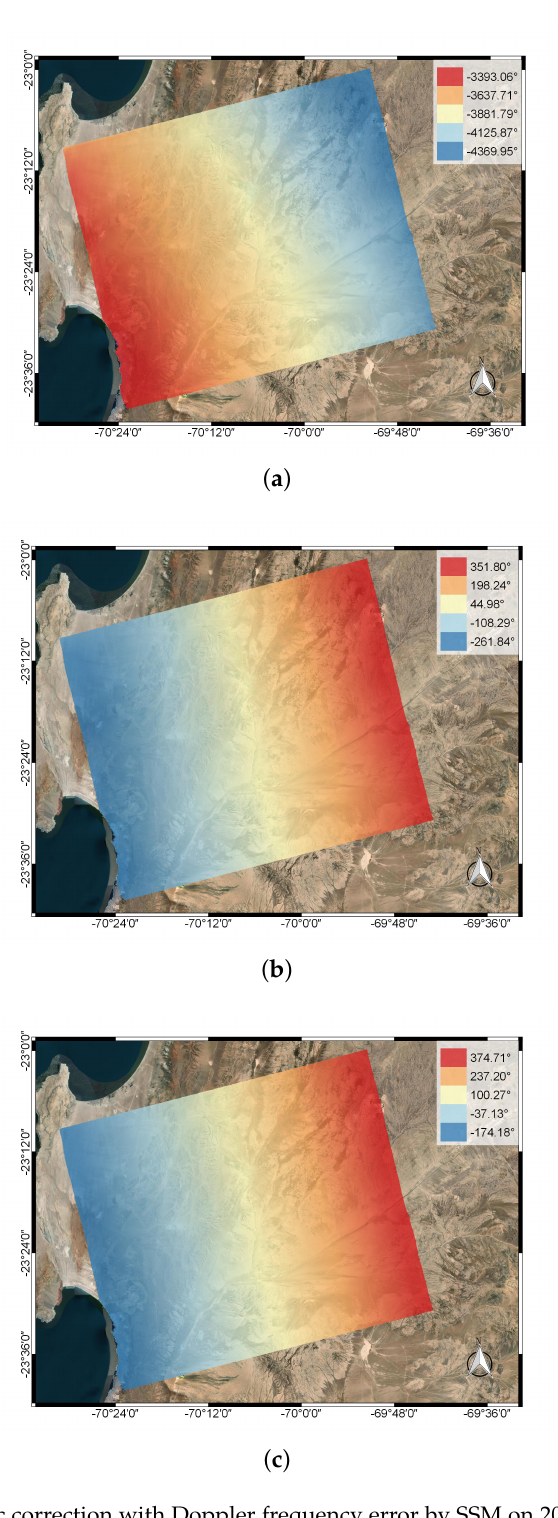
Figure 14. Ionospheric correction with Doppler frequency error by SSM on 20100623 and 20100808: ( a ) Ionospheric phase delay. ( b ) Corrected DInSAR phase. ( c ) Corrected DInSAR phase